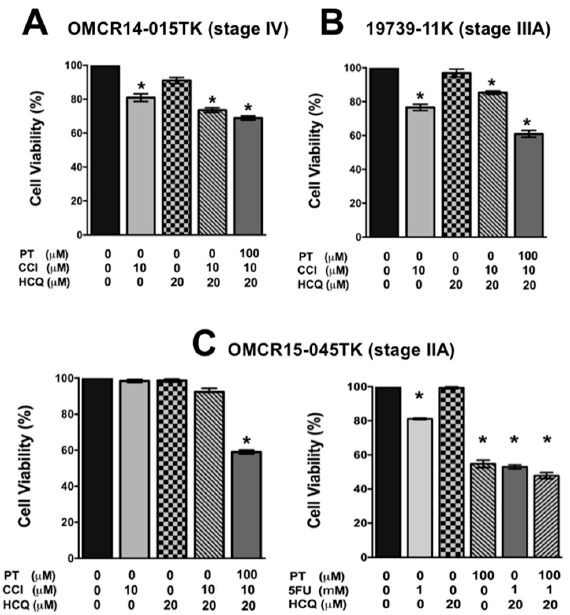
Figure 6. A specific HIF-2 α heterodimerization antagonist (PT-2385) also overcame the